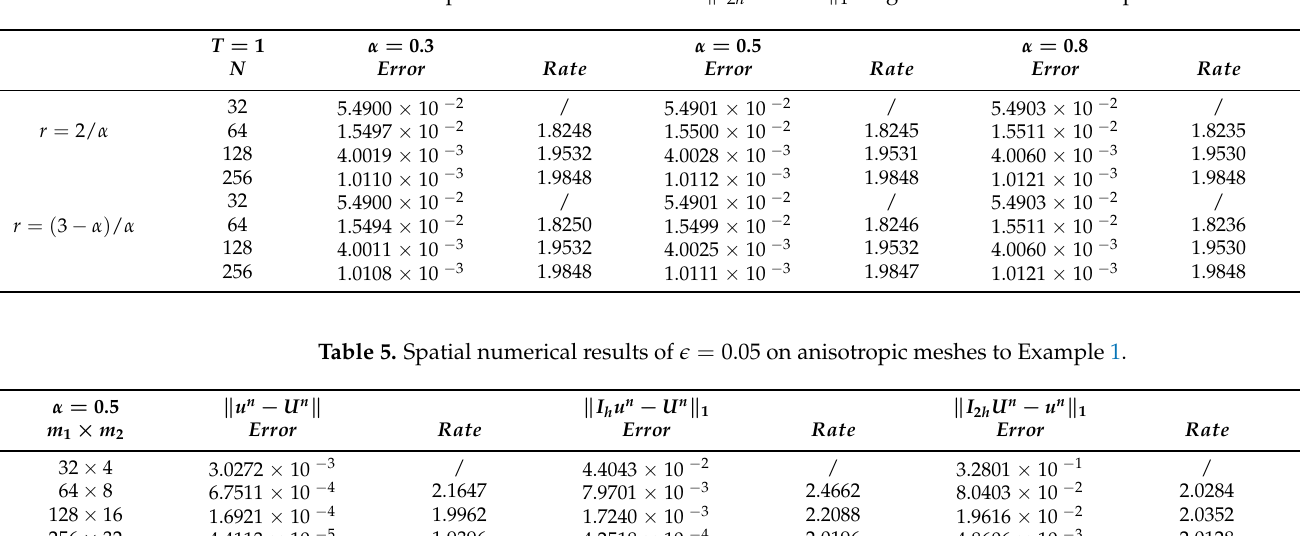
Table 4. Temporal numerical results of (cid:107) I 2 h U n − u n (cid:107) 1 on graded meshes to Example 1.